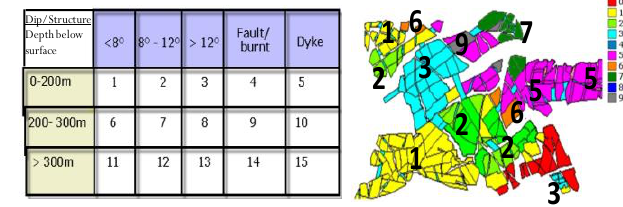
Figure 4: Operational performance matrix and the associated classified ore